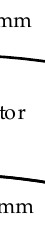
Figure 20. Diagram of the positions of test points A and B.